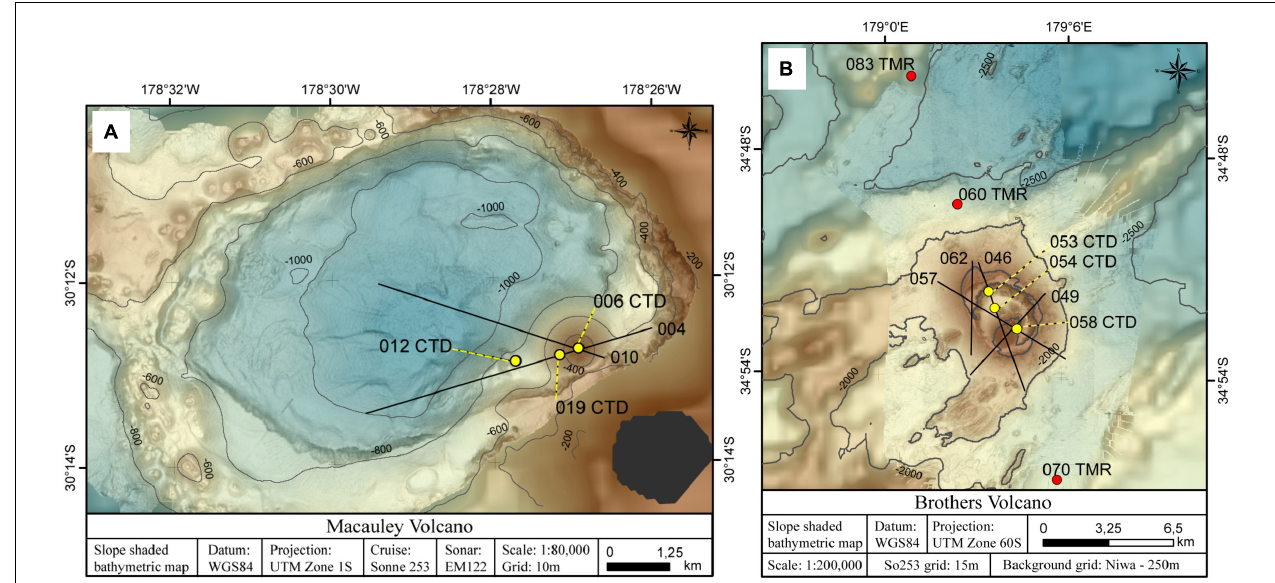
FIGURE 2 | Bathymetric map of the two active submarine volcanoes Macauley (A) and Brothers (B) including the sampled vertical CTDs (yellow dots), TMRs (red dots), and conducted tow-yos (black lines)© Dr. Janis Thal, University of Bremen.